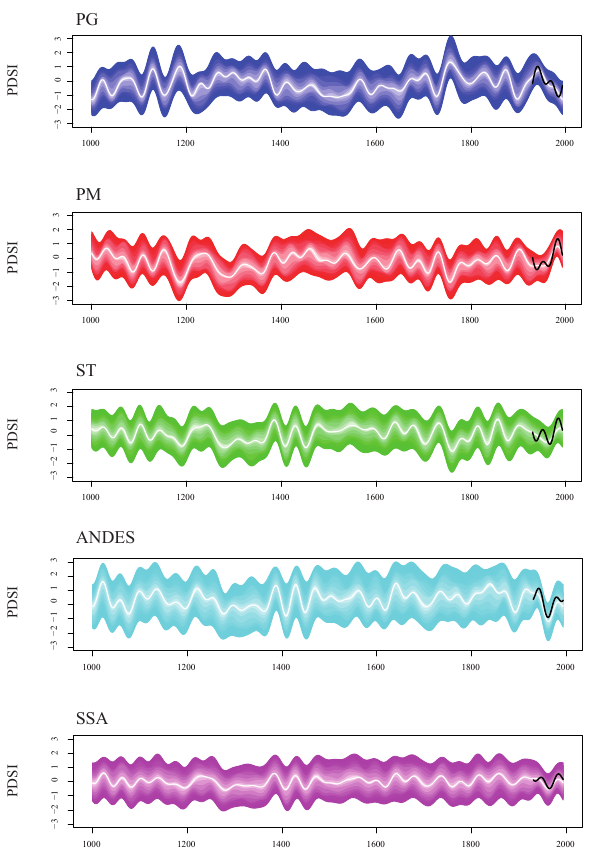
Fig. 10. Millennial summer PDSI reconstructions for each region Figure 10. Millennial summer PDSI reconstructions for each region of SSA. 30-year of SSA. 30-yr filtered chronologies are presented. Observations are filtered chronologies are presented. Observations are in black and reconstructions are in white. Colored shadings correspond to 95% confidence intervals (darker at each 5% incre- in black and reconstructions are in white. Colored shadings corre- ment). The color code is the same as in Figure 3. spond to 95% confidence intervals (darker at each 5% increment). The color code is the same as in Fig. 3.